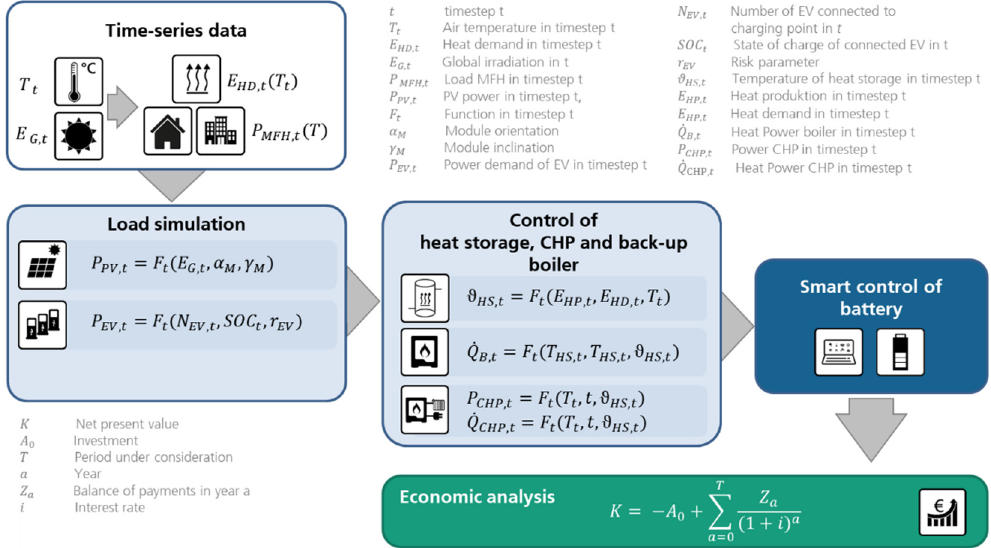
Figure 1. Overview of the developed simulation model of decentralised energy systems. Based on time-series data in minute resolution ( upper part ), the power output of PV is simulated as well as EV charging. The control of CHP, heat storage and back-up boiler is modelled as a simple heuristic ( central part ). Smart control of battery and charging infrastructure can be simulated with different objectives ( right part ). The simulation results are an input for the subsequent economic analysis ( lower part ).